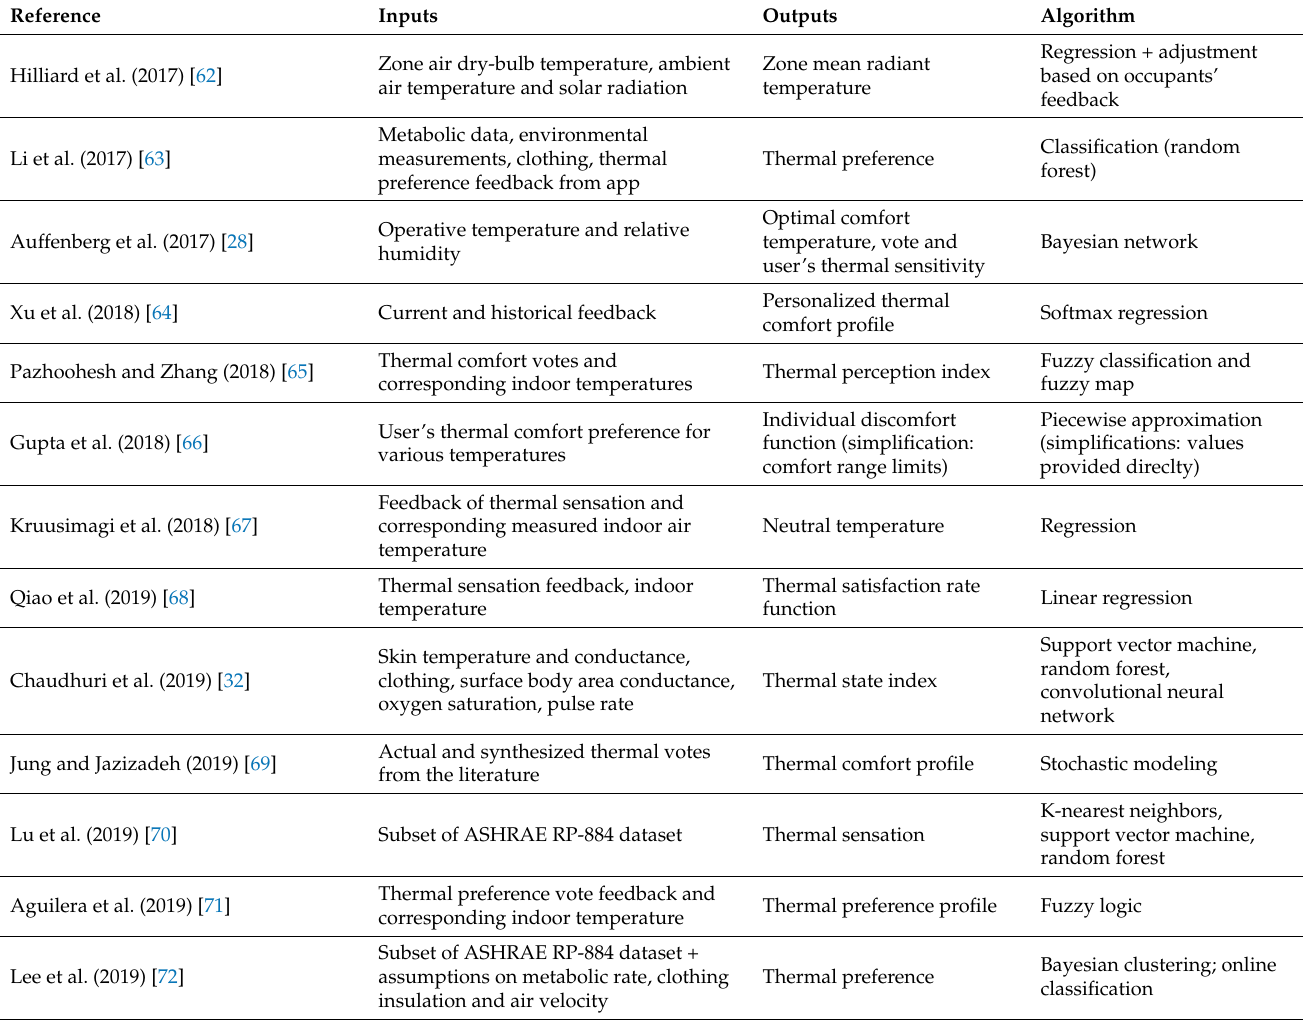
Table 5. Data-driven thermal comfort models in reviewed journal articles